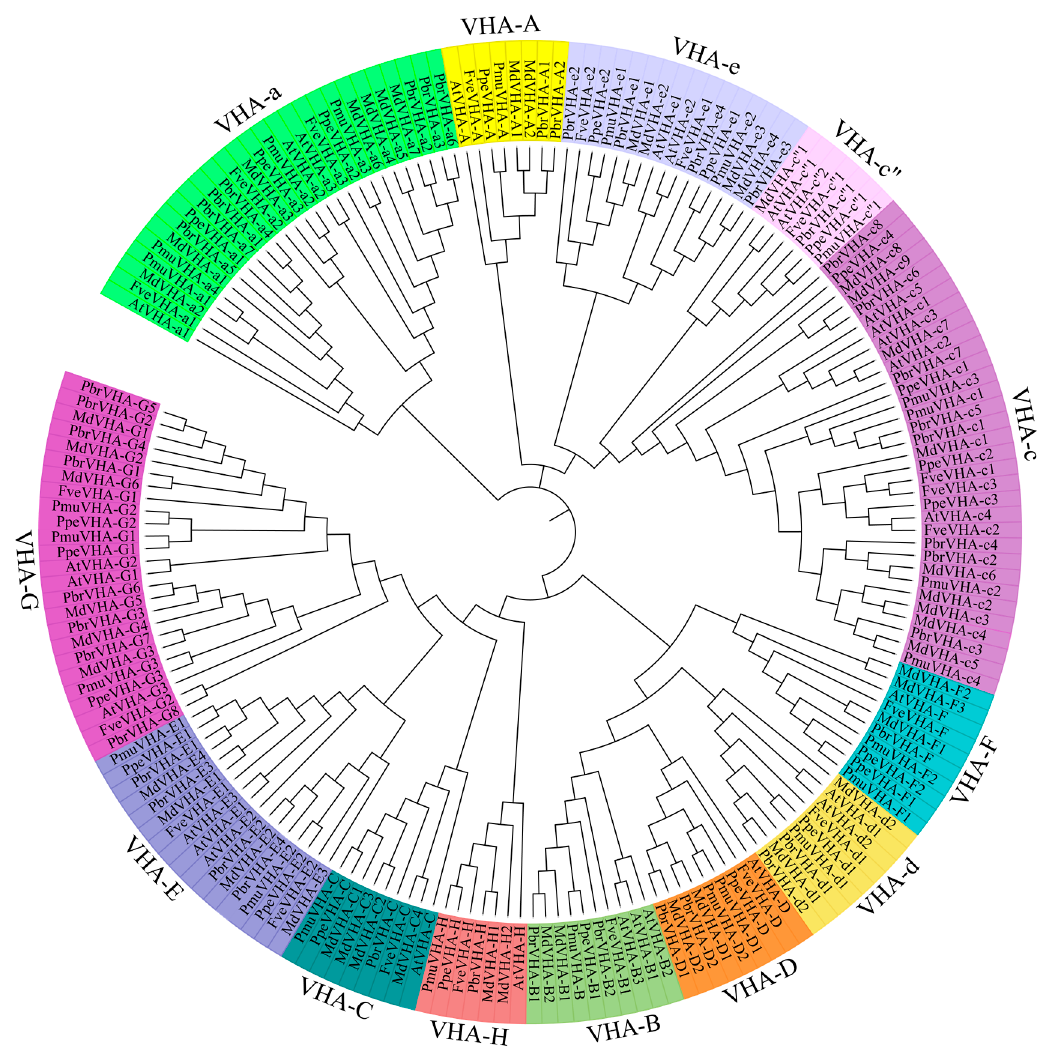
Figure 1. Phylogenetic analysis of V-ATPase proteins from Arabidopsis and five Rosaceae species ( Fragaria vesca, Prunus persica, Prunus mume, Pyrus bretschneideri and Malus x domestica ). The phylogenetic tree was constructed using MEGA6.0 software (http://www.megasoftware.net/) by neighbor-joining method and diagram was drawn using online tool (iTOL, https://itol.embl.de/). The different colour indicate different subfamily respectively.